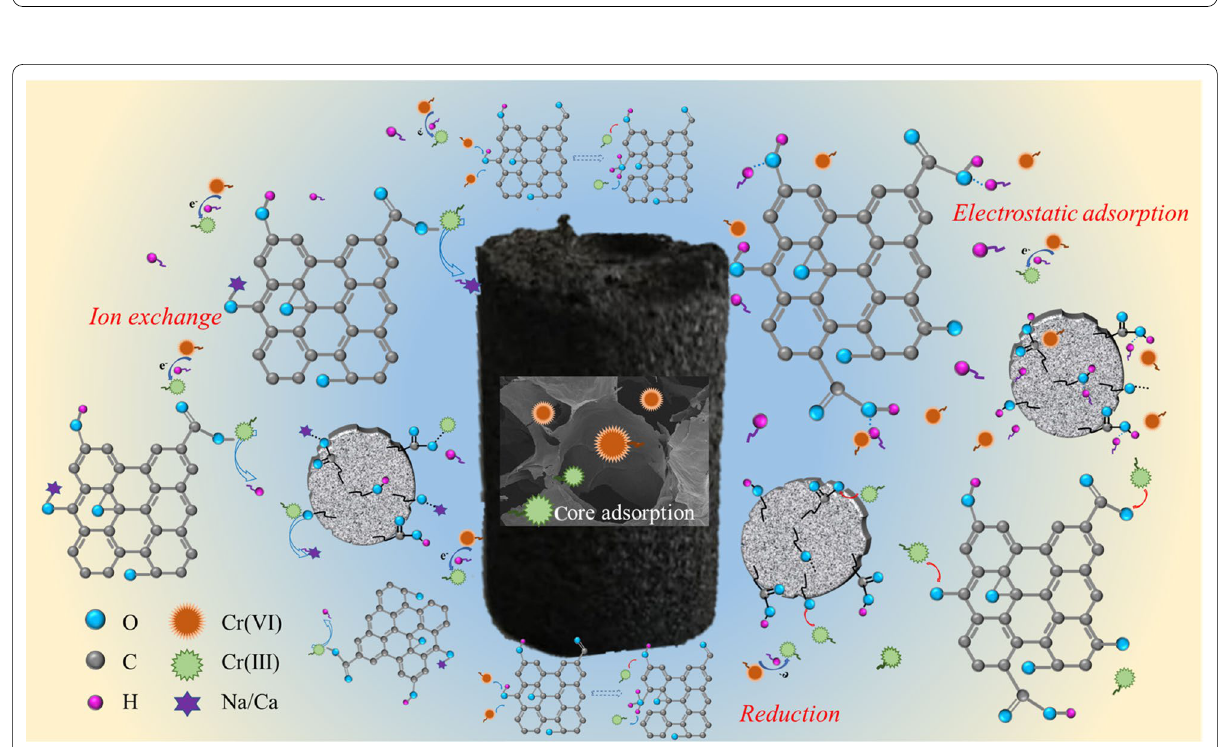
Fig. 10 C 1s spectra of rGA and BC/rGA before and after adsorption